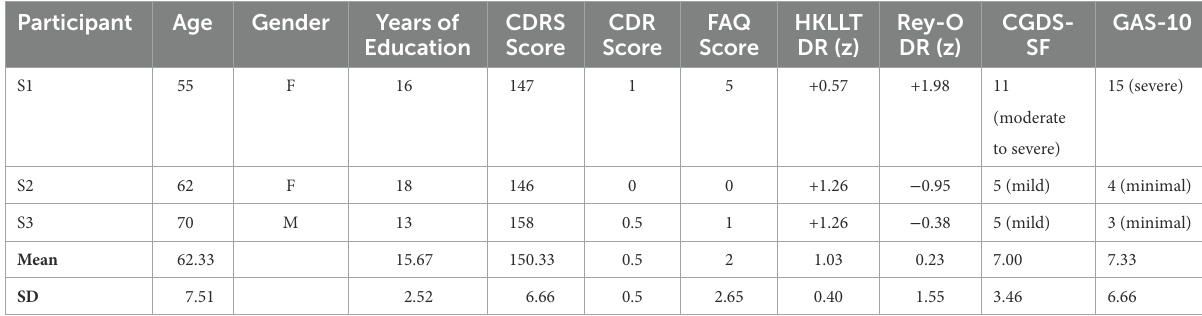
TABLE 1 Demographics and test scores of each older adult at